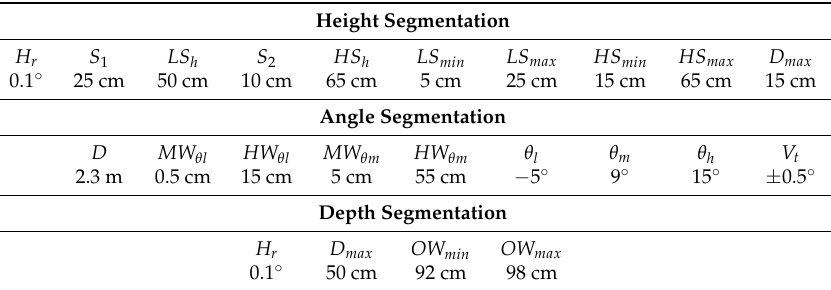
Table 2. Parameters used in the